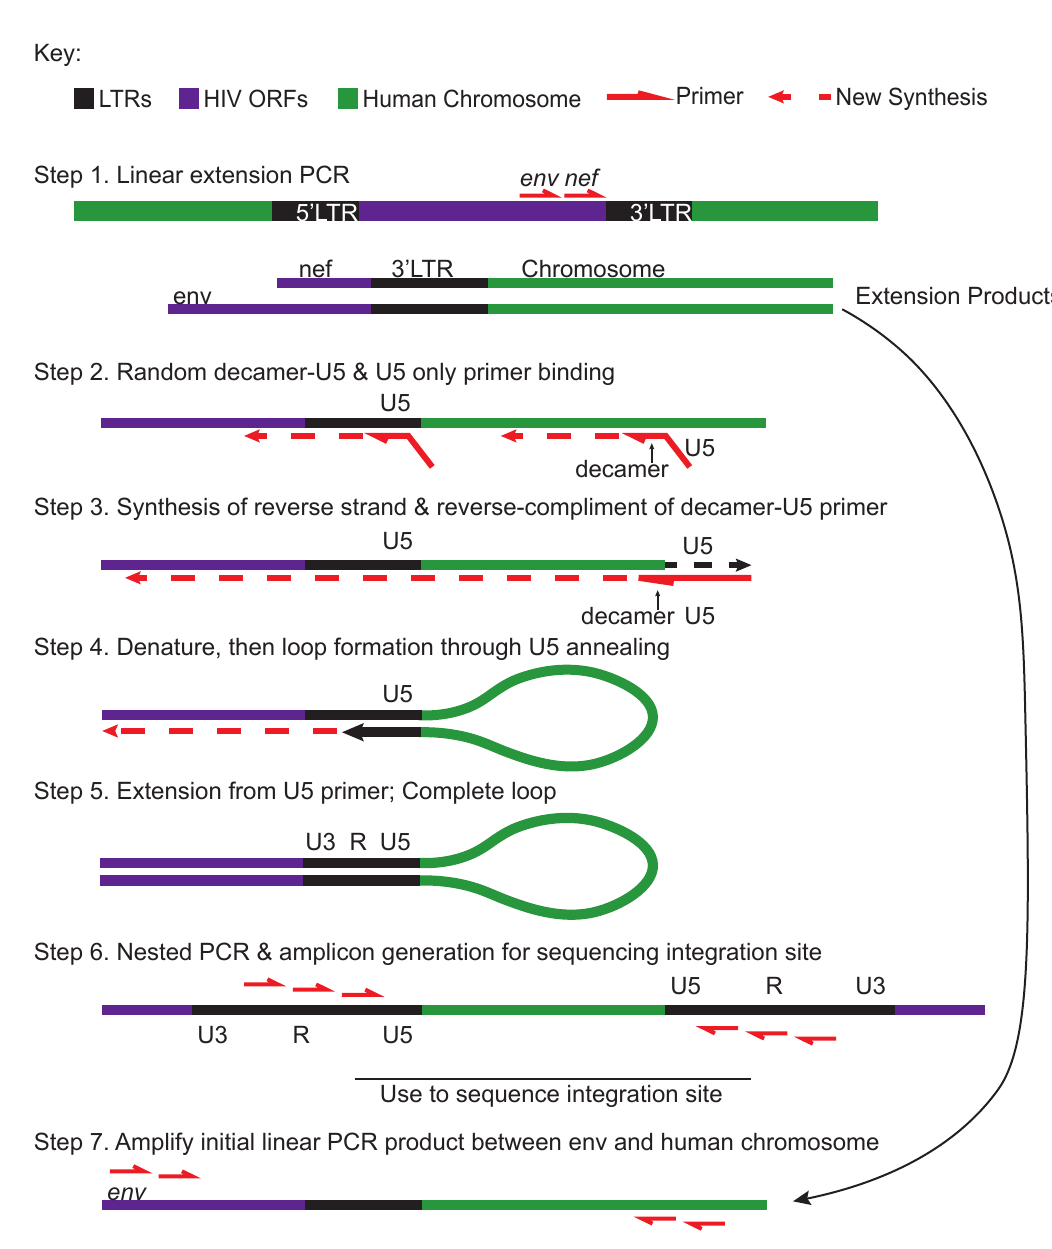
Figure 5. Integration site loop amplification (ISLA). Modified from [76]. Black segments represent long-terminal repeat (LTR) regions; purple, HIV open reading frames (ORFs); green, human chromosomal